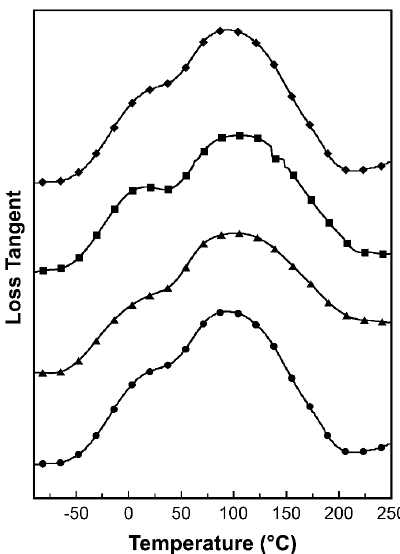
Figure 8. Loss tangent curves of MWCNT reinforced V-fa/ECO composites at MWCNT contents of ( ● ) 0 wt%, ( ▲ ) 0.1 wt%, ( ■ ) 0.3 wt%, and ( ♦ ) 0.5 wt%.